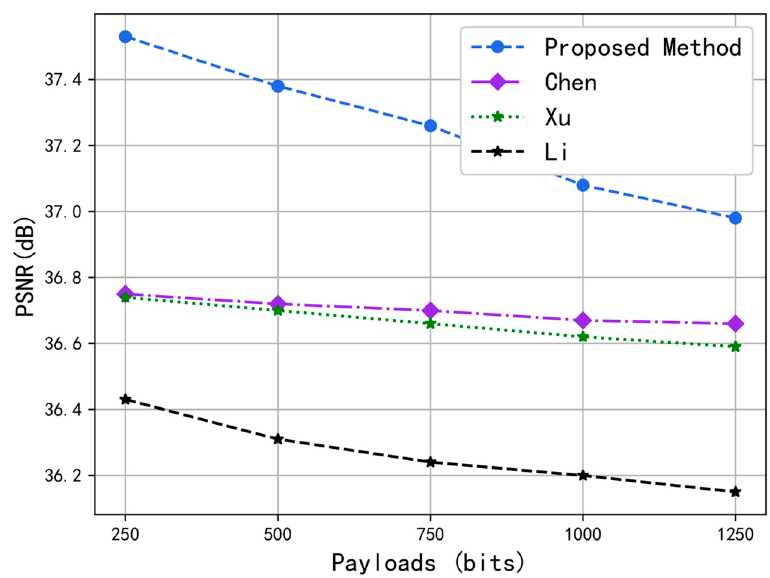
Figure 7. Comparison of PSNR values of different schemes on Container.